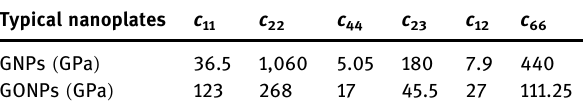
Table 1: The adopted elastic constants of typical GNPs and